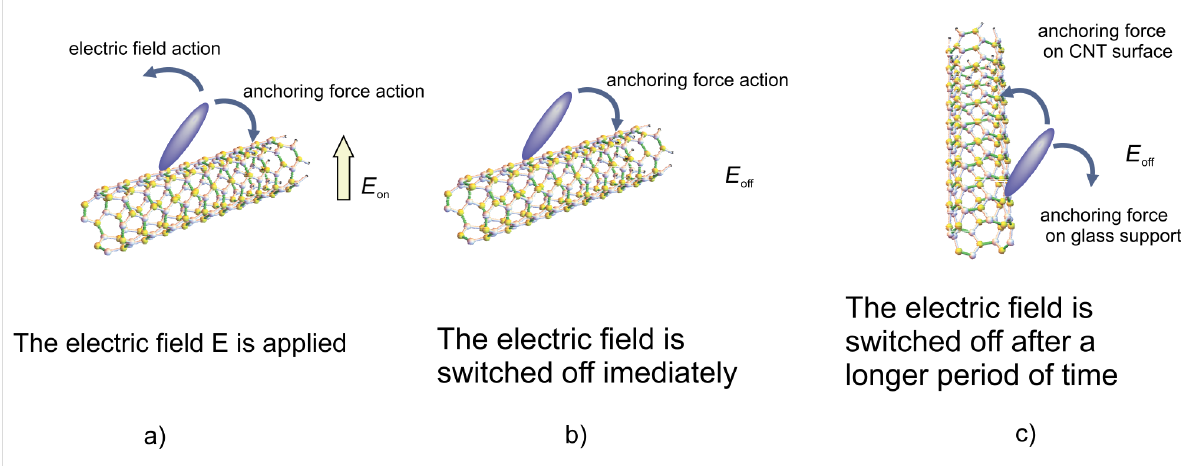
Figure 4: Relative orientation of a liquid crystal molecule on a carbon nanotube surface. a) The electric field is applied, b) the electric field is switched off immediately, c) the electric field is switched off after a longer period of time.